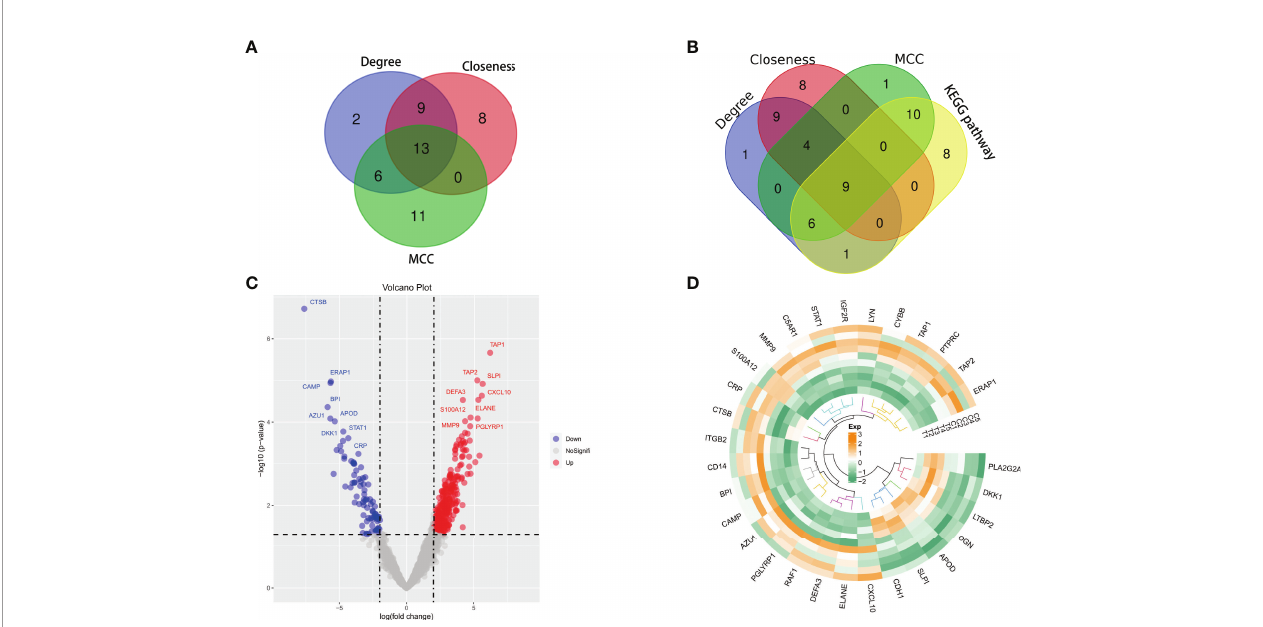
FIGURE 9 | (A, B) Venn diagrams were plotted. (A) Cytoscape software calculated the hub 30 key proteins by Closeness, Degree, and MCC methods, respectively. A total of 13 hub proteins were obtained by the intersection of three methods. (B) There were 9 key proteins in the intersection of the hub proteins calculated by Cytoscape and the proteins of the Coronavirus disease-COVID-19 pathway. (C, D) Differential analysis of immune-related genes. (C) 30 immune-related genes include 7 down-regulated genes and 23 up-regulated genes. (D) The circus heatmap clearly showed the clustering of all the immune-related genes in STB tissue and non-TB spinal